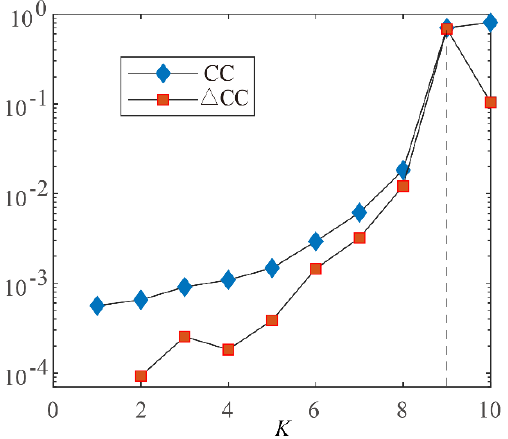
Figure 6. The values of Pearson’s correlation coefficient ( CC ) and their difference △ CC of the ten components decomposed by VMD.